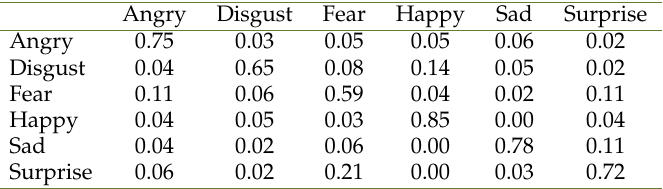
Table 2. Multi-modal emotion recognition accuracy with AHP fusion Angry Disgust